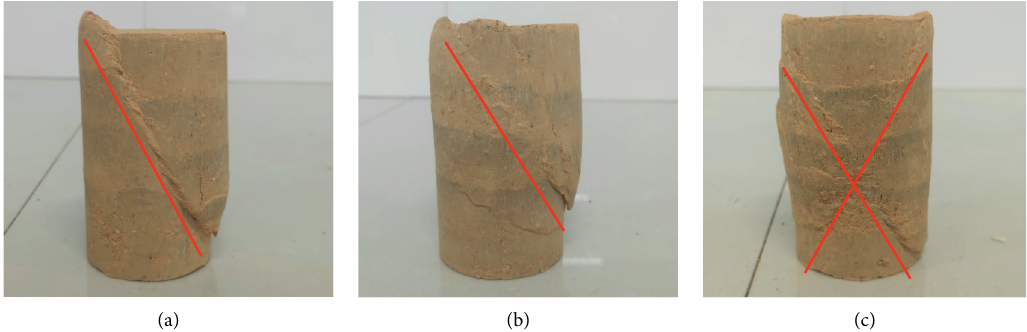
Figure 8: Failure mode of soil specimens with K � 0.98 and n � 0: (a) σ